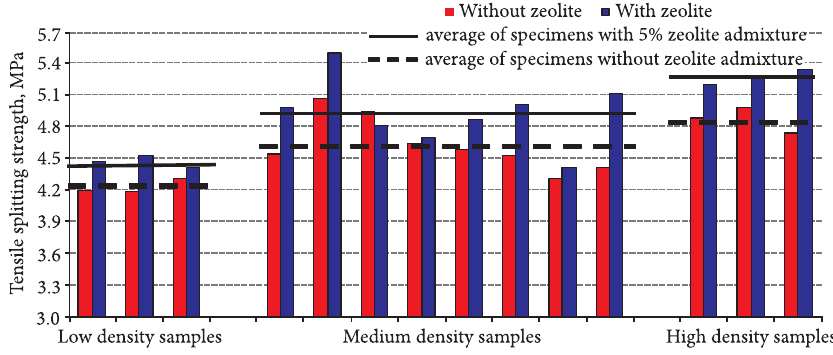
Fig. 8. Tensile splitting strength of paving blocks after 28 days of curing